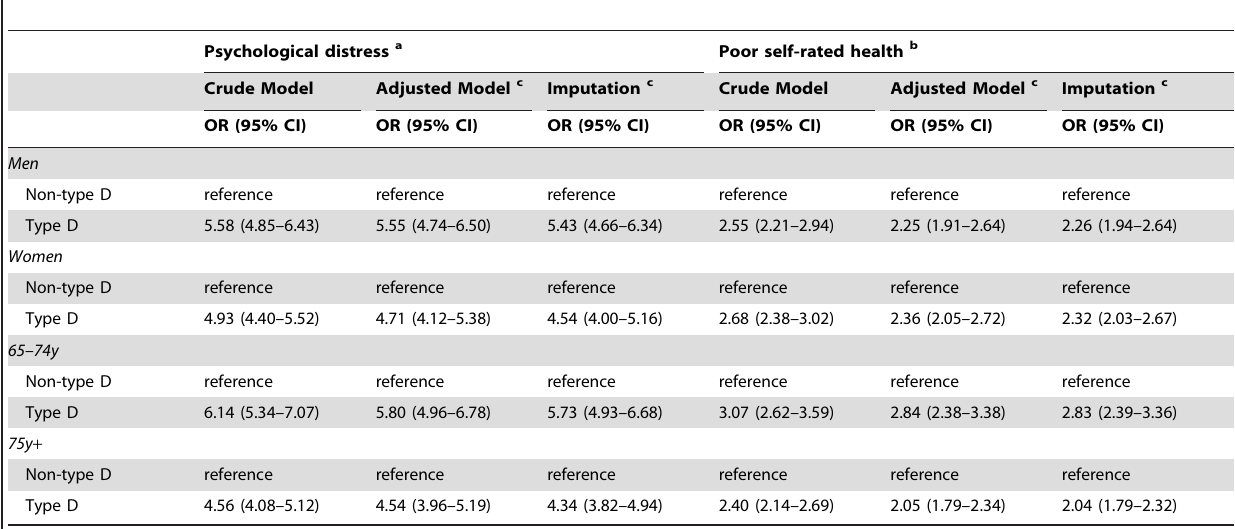
CI: confidence interval, OR: odds ratio. a Psychological distress denotes K6 score of 5 or higher. b Poor self-rated health denotes that participant answered either "Fair" or "Poor." c Adjusted for age, sex, smoking status, frequency of alcohol consumption, overweight status, educational attainment, socioeconomic status, and number of cohabiters. doi:10.1371/journal.pone.0077918.t003 PLOS ONE |